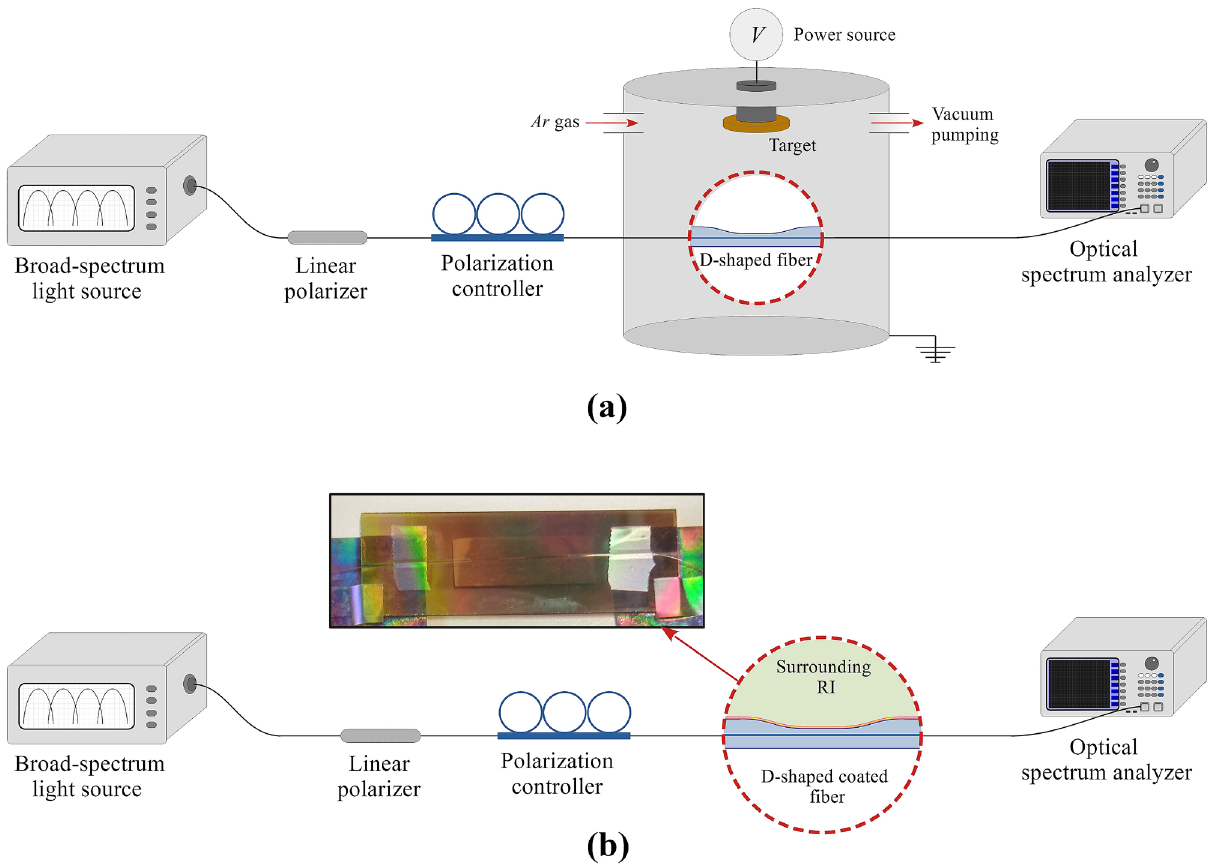
Figure 6. ( a ) Schematic of the experimental setup used for the thin film deposition. To observe the evolution of the optical spectrum during the thin film deposition, the pigtails connected to the polarization controller and the optical spectrum analyzer enter the sputtering machine via feedthroughs. ( b ) Schematic of the experimental setup used for the characterization of the devices as refractometers. The system allows controlling the polarization of light in order to visualize the TE resonance in the optical